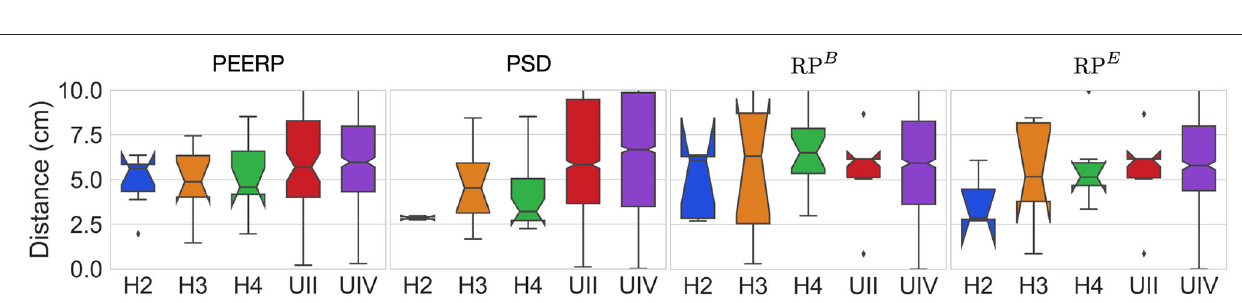
FIGURE 10 | Geodesic distance between inducing points and centers of the path covered by stable llPSs.